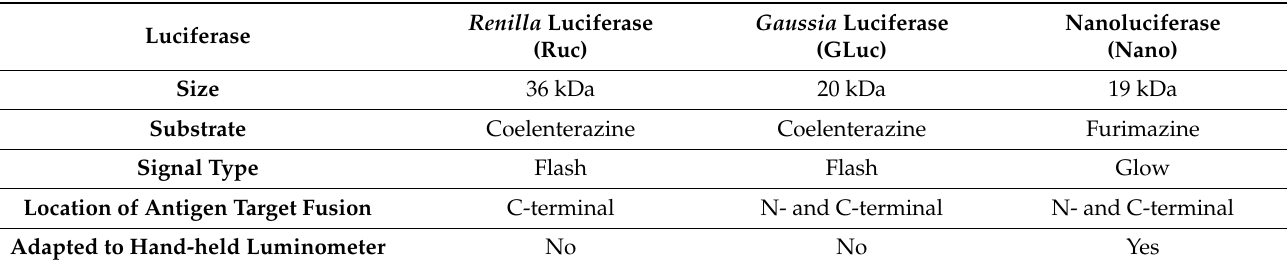
Table 1. Luciferases used for Antigen Fusion for LIPS